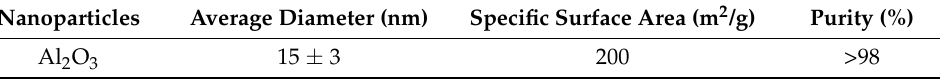
Table 2. NA properties